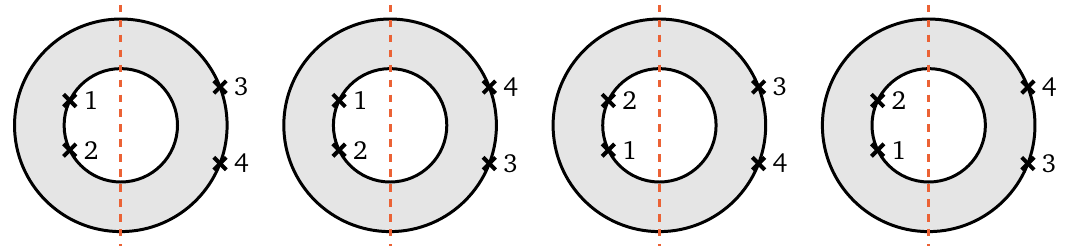
Figure 18: The four cuts of the non-planar annulus diagram in the s -channel corre- sponding to the four regions Γ ( 1 ) ,..., Γ ( 4 ) in this